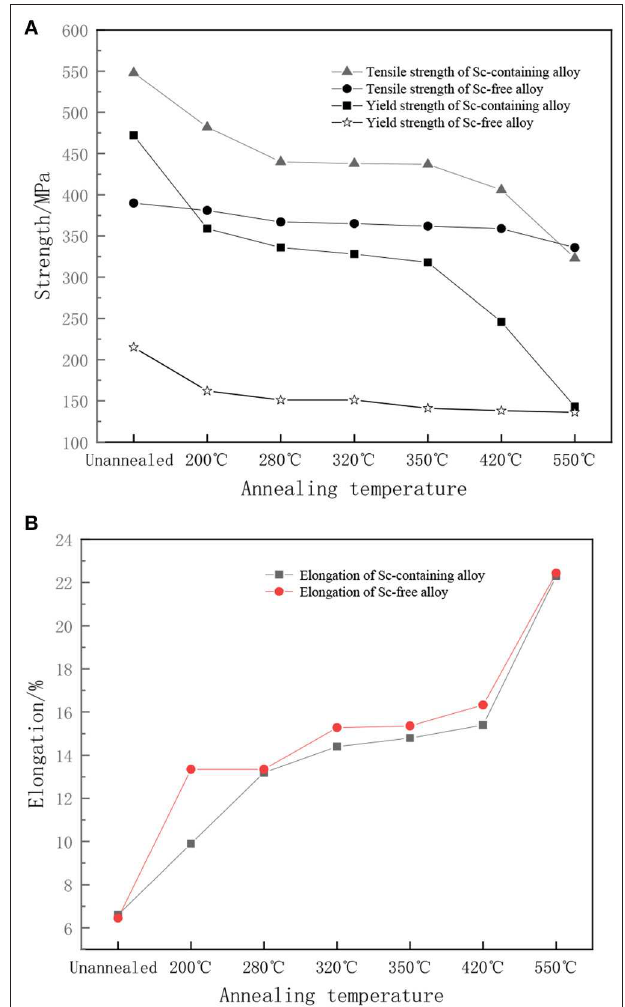
FIGURE 1 | Influence of annealing temperature on mechanical properties of Sc-free alloy and Sc-containing alloy. (A) Tensile and yield strengths. (B)